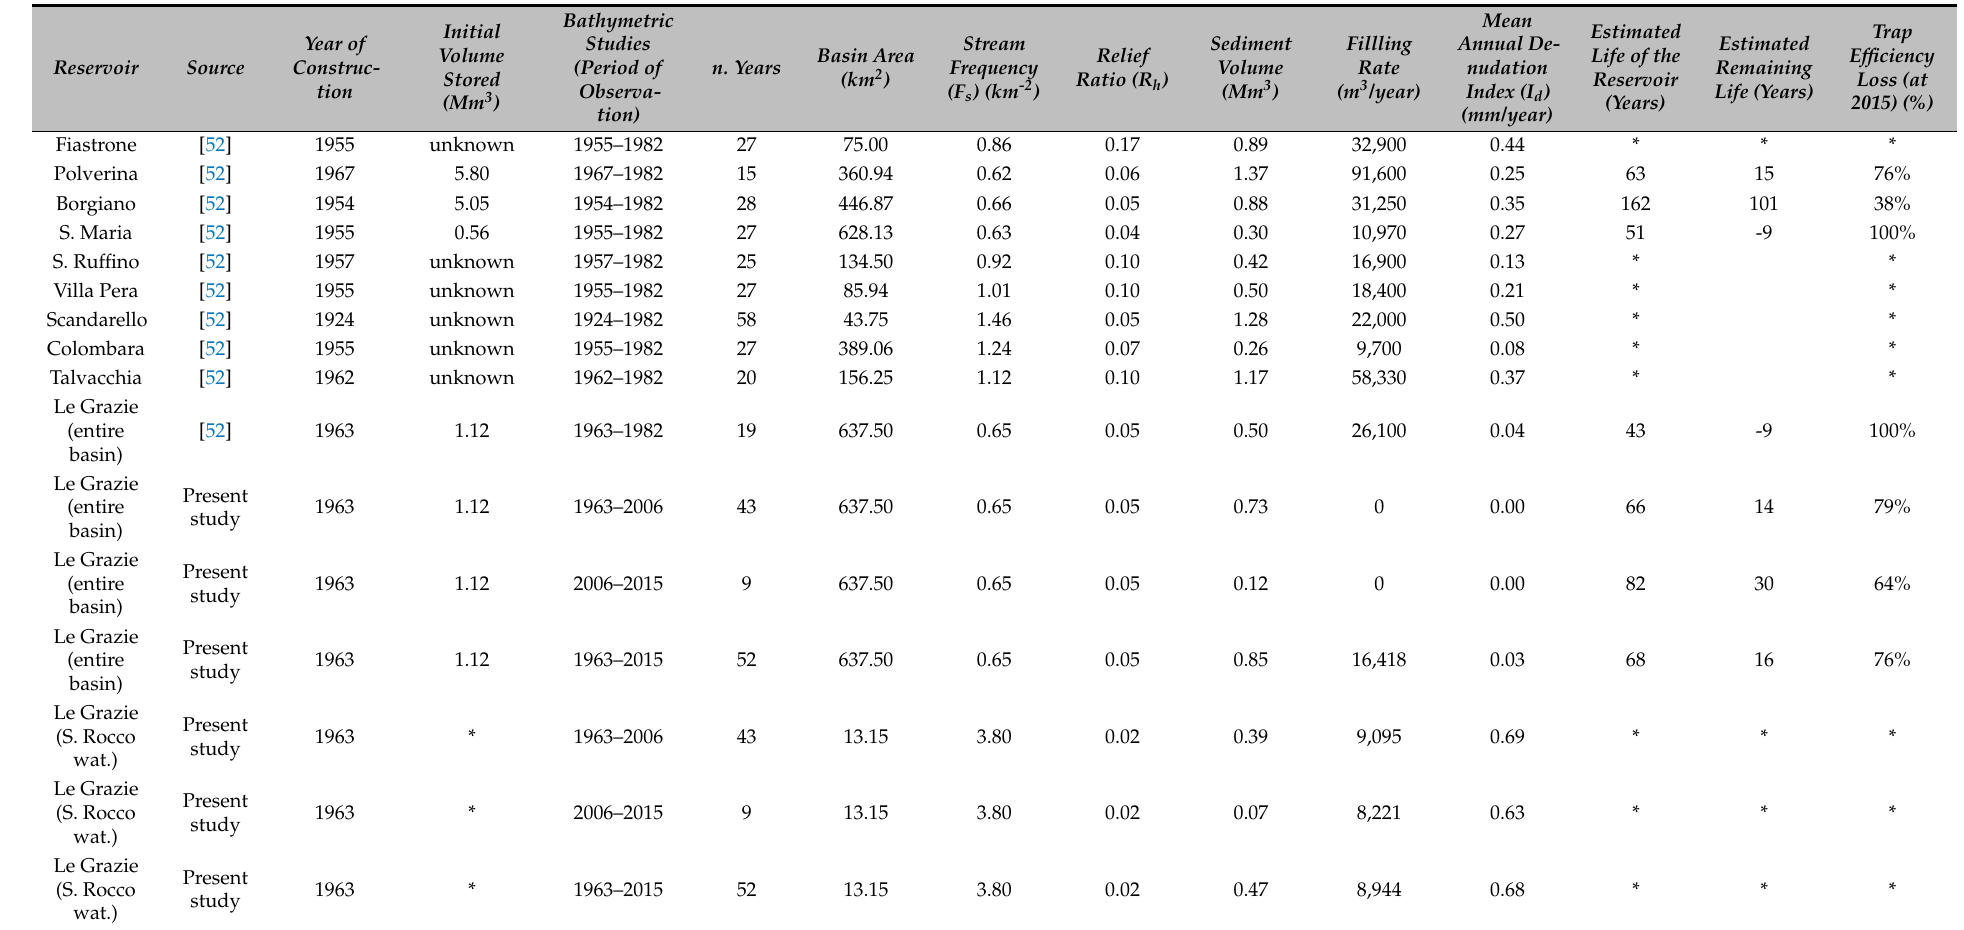
Table 6. Synthesis of the data collected and of the morphometric analysis concerning the reservoirs described in the present study. The asterisk (*) indicates uncalculated